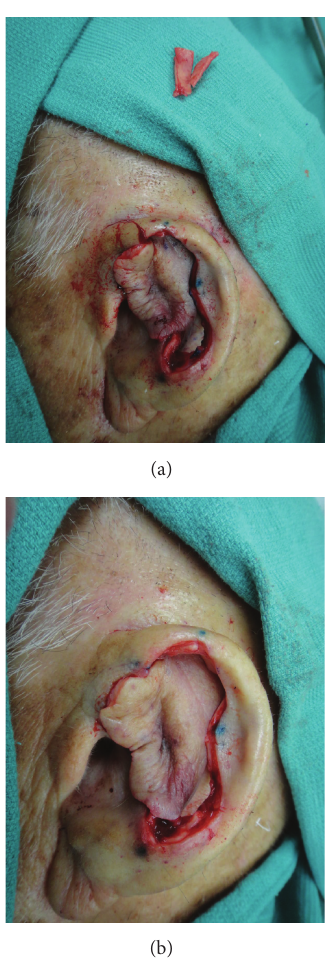
Figure 4: A 1.5cm 2 cartilage graft was harvested from scaphoid fossa and attached to the antihelix region with quilting sutures. The postauricular skin was folded forward through the cartilage window to cover the cartilage